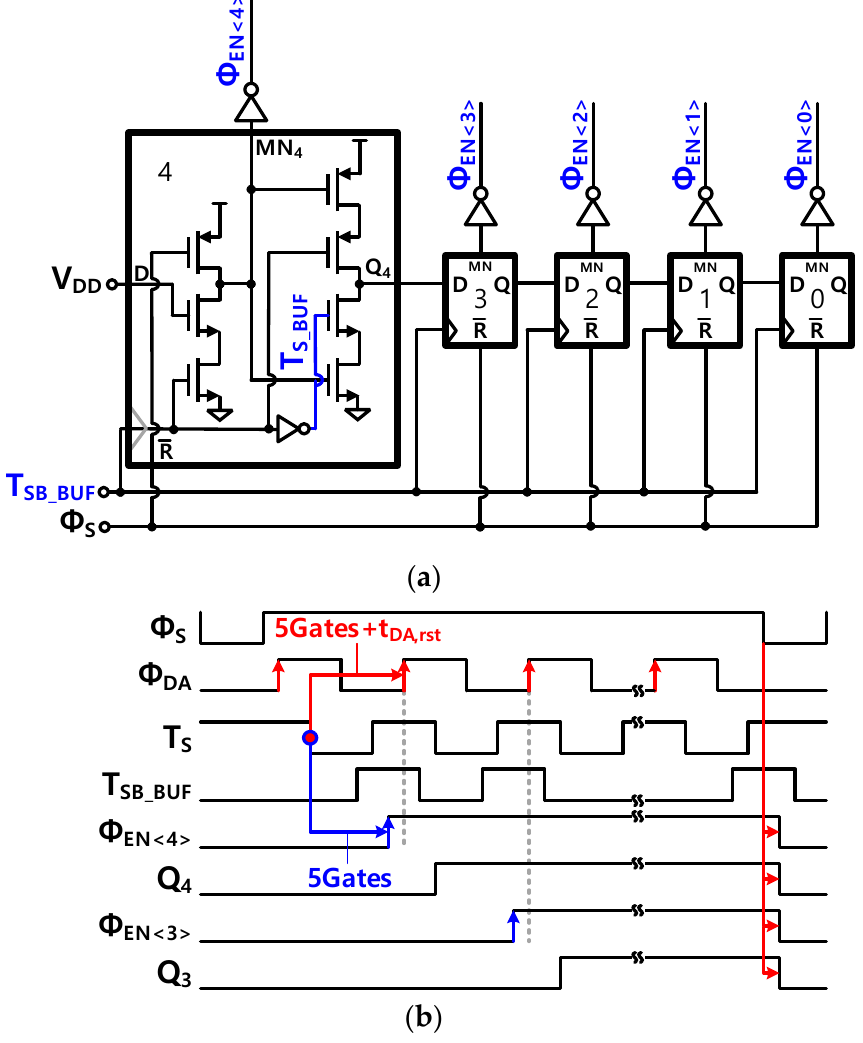
Figure 8. Latch EN GEN with domino logic using tri-state inverters. ( a ) Block and ( b ) timing diagrams. Figure 9 provides the simulation results of ∆ T 2 with 1000 samples. Despite the supply and temperature variation, ∆ T 2 was always positive and larger than 5 ps. This means that each Φ EN was ready earlier than the rising of Φ DA , as